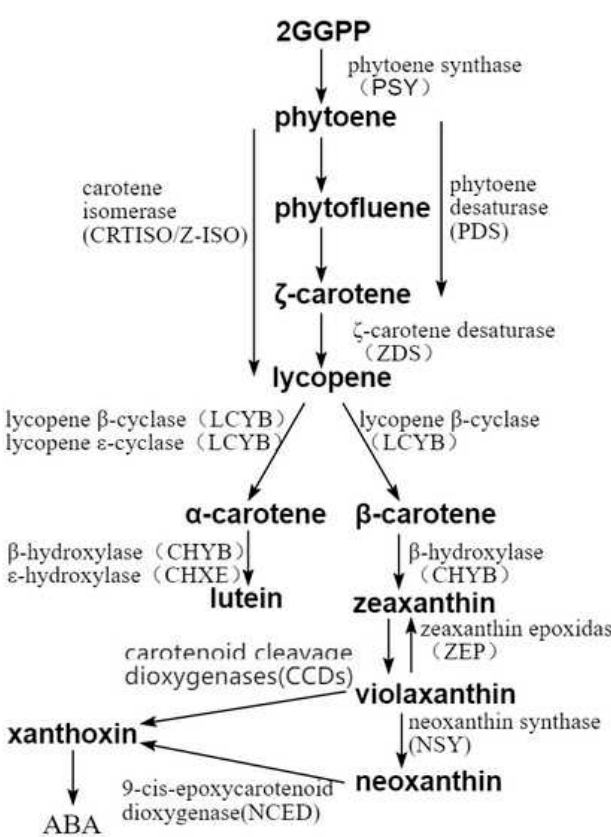
Figure A1. The biosynthetic pathway of carotenoids in plants. Table A1. The content of PT, PTF and LYC in mixed raw material.